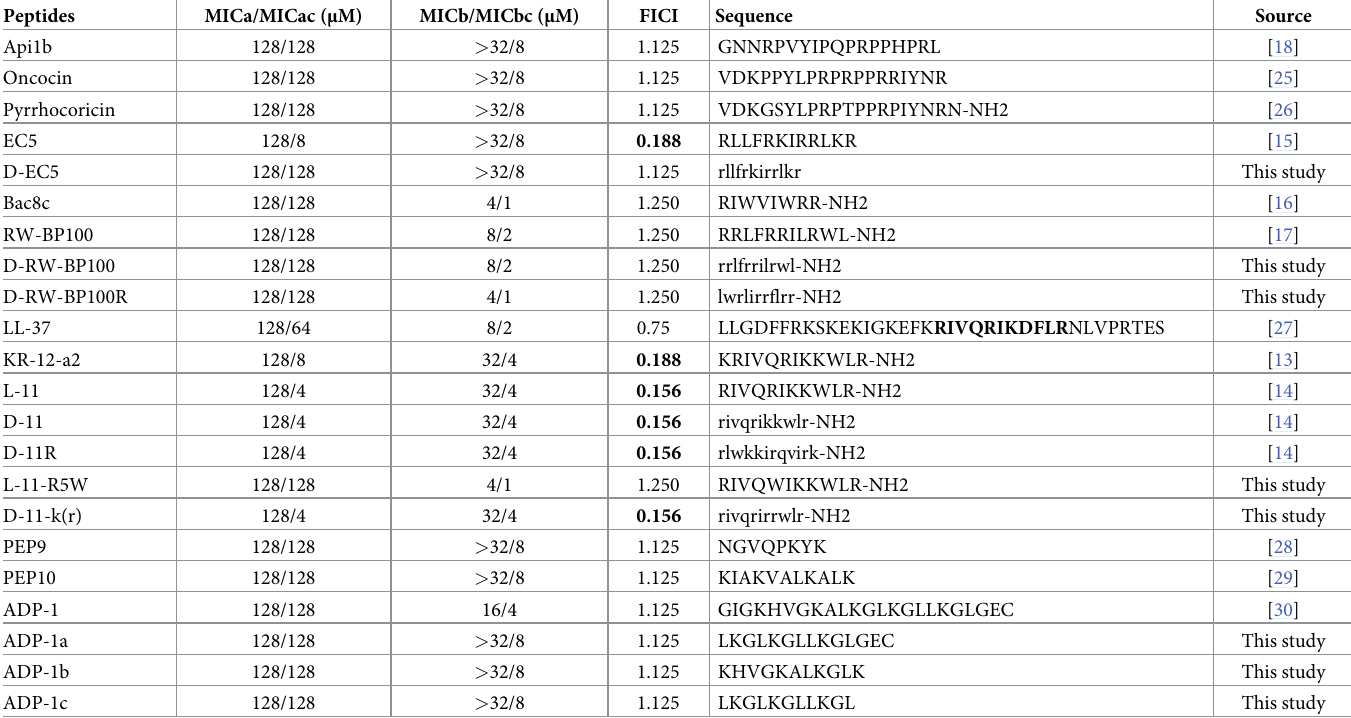
MICa: the MIC of azithromycin, MICb: the MIC of the peptide, MICac: the MIC of azithromycin in the combination, MICbc: the MIC of the peptide in the combination, the synergy effects were bolded in FICI. Peptides with capital letters mean they are synthesized with L-type amino acids, peptides with lowercase letters mean they are synthesized with D-type amino acids, red marks mean amino acid changes. D-11 and its variants were derived from the sequence that was bolded in LL- 37